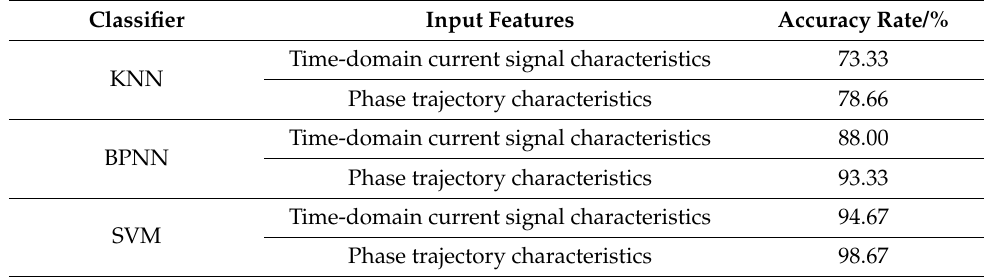
Table 4. Accuracy of different classification models and input